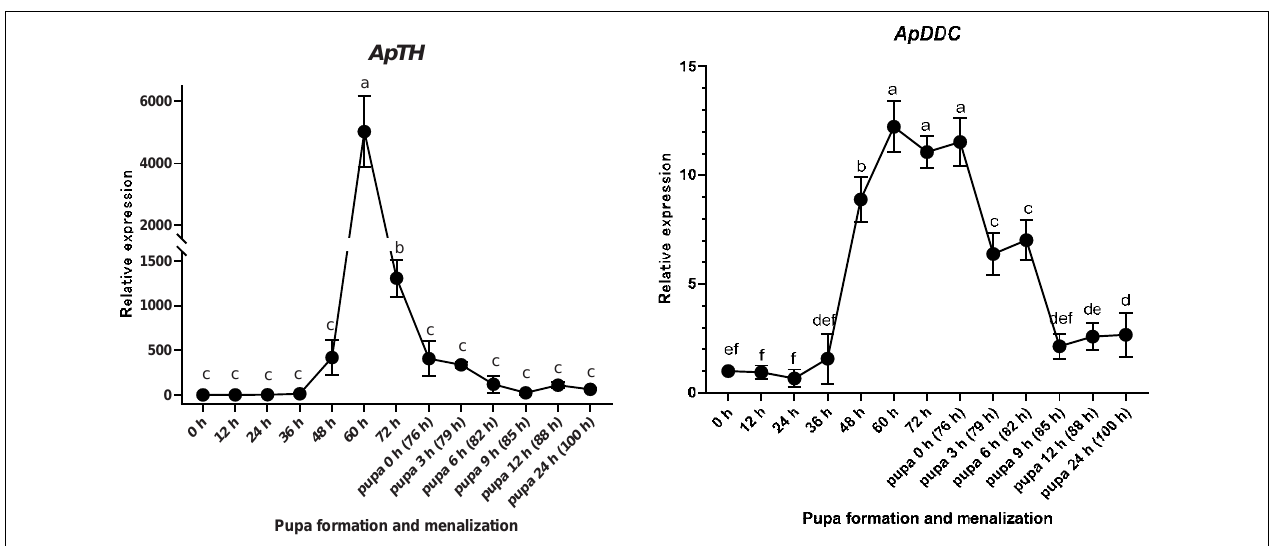
FIGURE 4 | Relative expression of ApTH and ApDDC in tissues was quantified by semi-quantitative RT-PCR. The reference gene was β -actin , two different time (24 h and 60 h) were selected for PCR amplification in tissues.